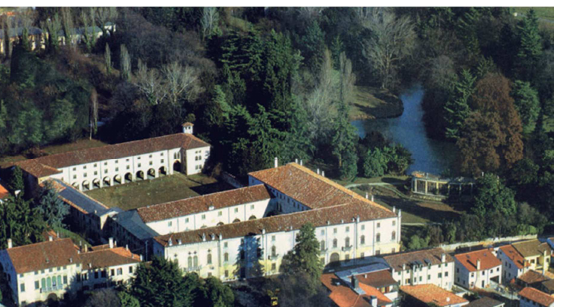
Figure 5: Aerial view of the complex building of Villa Bolasco and the Park.